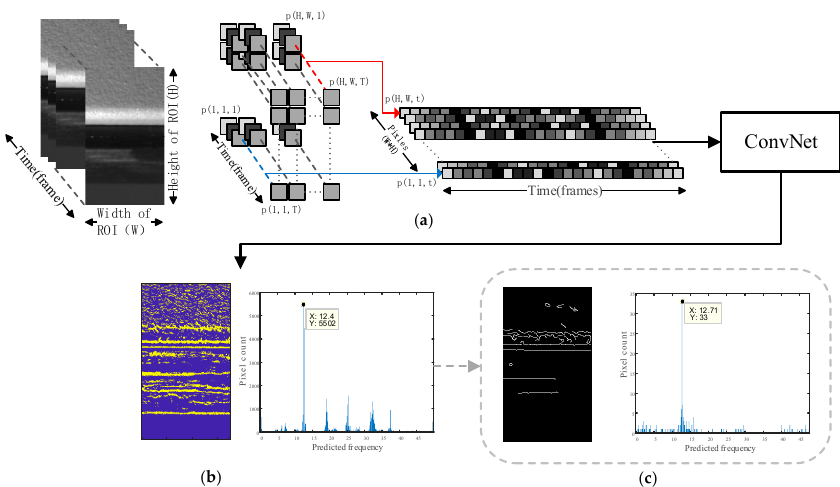
Figure 3. Implementation pipeline of the proposed method: ( a ) Read in the ROI video as image sequence and save as separate pixel brightness variation signals, then feed in the ConvNet; ( b ) Network output prediction result visualization; ( c ) Optional edge enhancement operation.